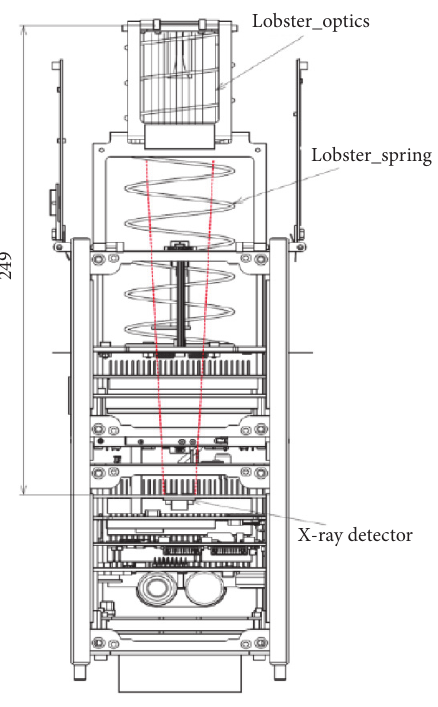
Figure 1: Optical layout of X-ray package inside VZLUSAT-1 satellite (image taken from [1]).